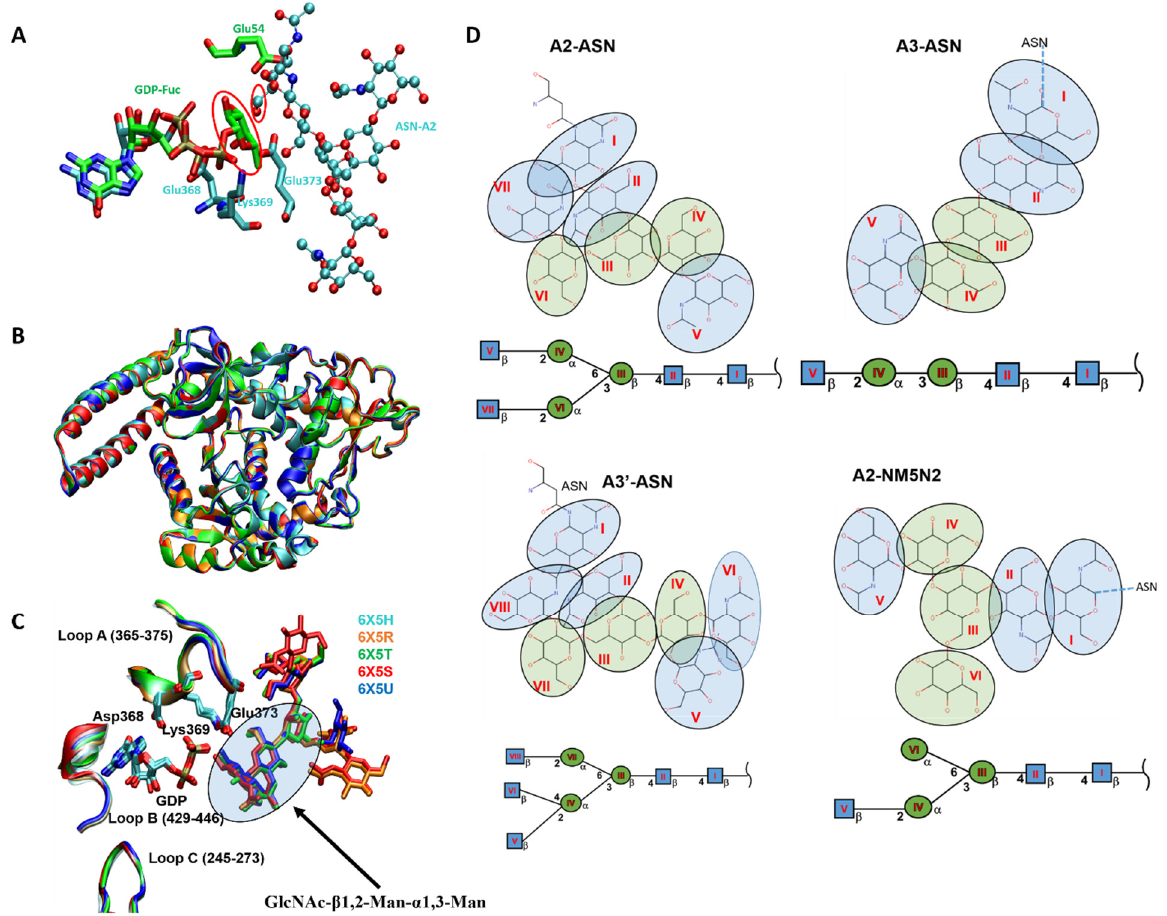
Figure 9. ( A ) The molecular interaction of Hs FUT8 with its substrates and its catalytic mechanism in humans. The GDP: Hs FUT8:A2-Asn ternary complex (PDB id:6X5R)is aligned with the GDP-Fuc: Hs POFUT2 binary complex (PDB id: 4AP6). The aligned structures overlay the nucleotide and ribose (cyan sticks for GDP bound to FUT8 and green sticks for GDP-Fuc bound to POFUT2) in both structures and place the fucose (green-circled sticks) in the active site of FUT8 for the fucose residue which is aligned for nucleophilic attack by the OH-6 of the GlcNAc-1 of A2-Asn. Both the fucose and OH-6 GlcNAc nucleophile are circled in red, and Glu373 is the catalytic base. ( B ) Alignment of human FUT8 in the presence of a donor substrate analog and with four distinct glycan acceptors. Cyan represents no glycan, orange represents ASN-A2 glycan, green represents ASN-A3, red represents ASN-A3 ′ , and blue represents ASN-NM5N2 glycan. ( C ) Close-up image of the active site of FUT8 in the presence of a donor substrate analog and four distinct glycan acceptors (superimposed). ( D ) Schematic representation of glycan acceptor structures.